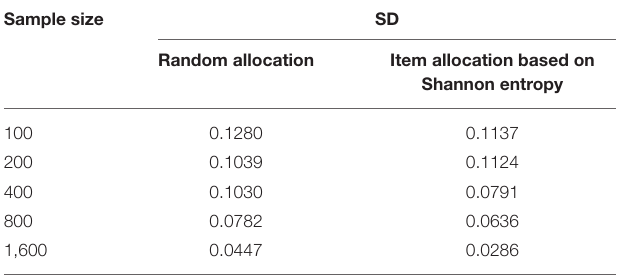
TABLE 3 | The standard deviation of the attribute vector under the two allocation strategies. Sample